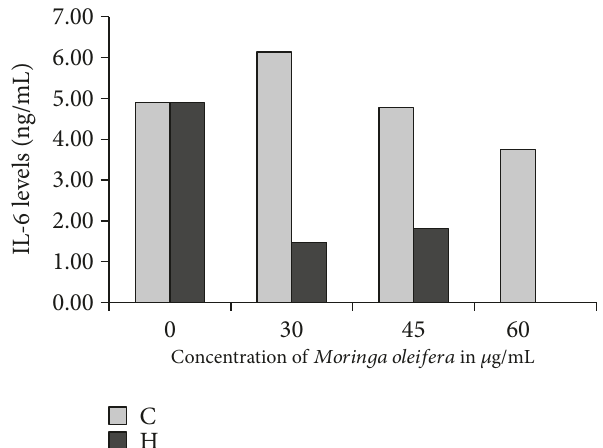
Figure 4: IL-6 levels after Moringa oleifera treatment determined in the supernatant of Huh7 cells transfected with genotypes C and H. A mixture from the triplicates from the cell culture supernatant of transfected Huh7 cells was prepared with proportional volumes. ELISA was performed with a capture-speci fi c mouse anti-human IL-6 antibody (100 μ L at 2 μ g/mL). After incubation and washing steps, detection was performed with Biotinylated Goat anti- human IL-6 detection antibody (100 μ L at 50ng/mL) using